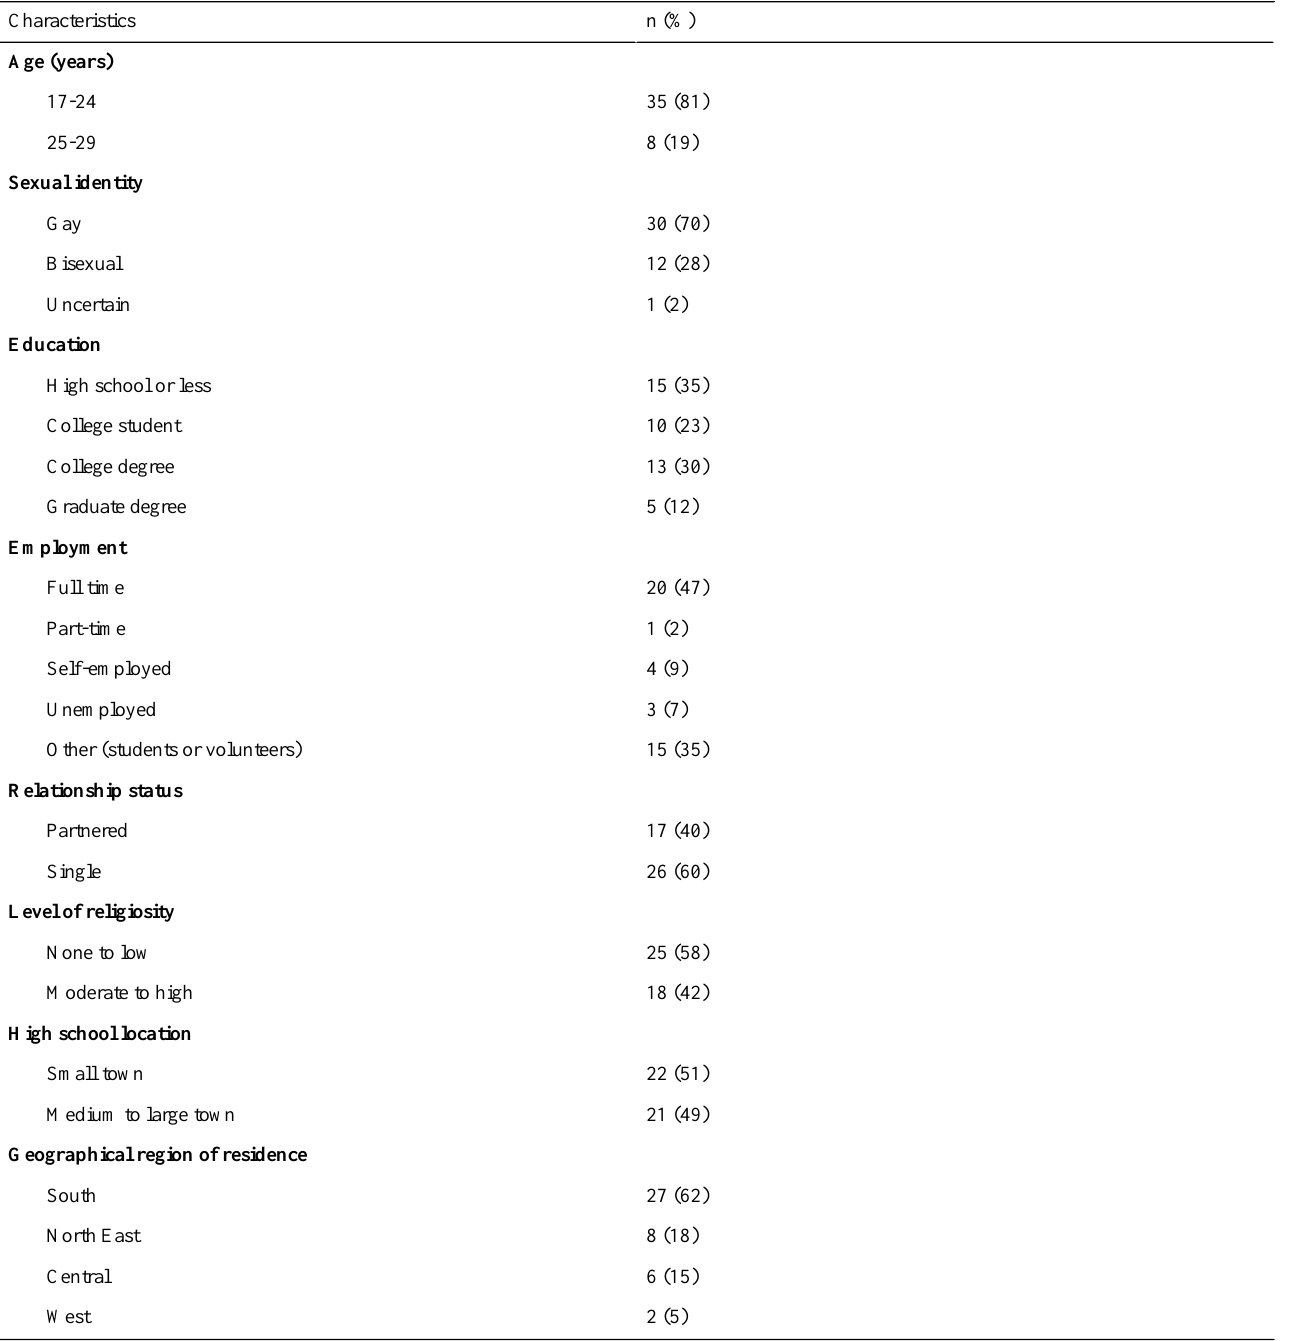
Table 1. Participant demographic characteristics